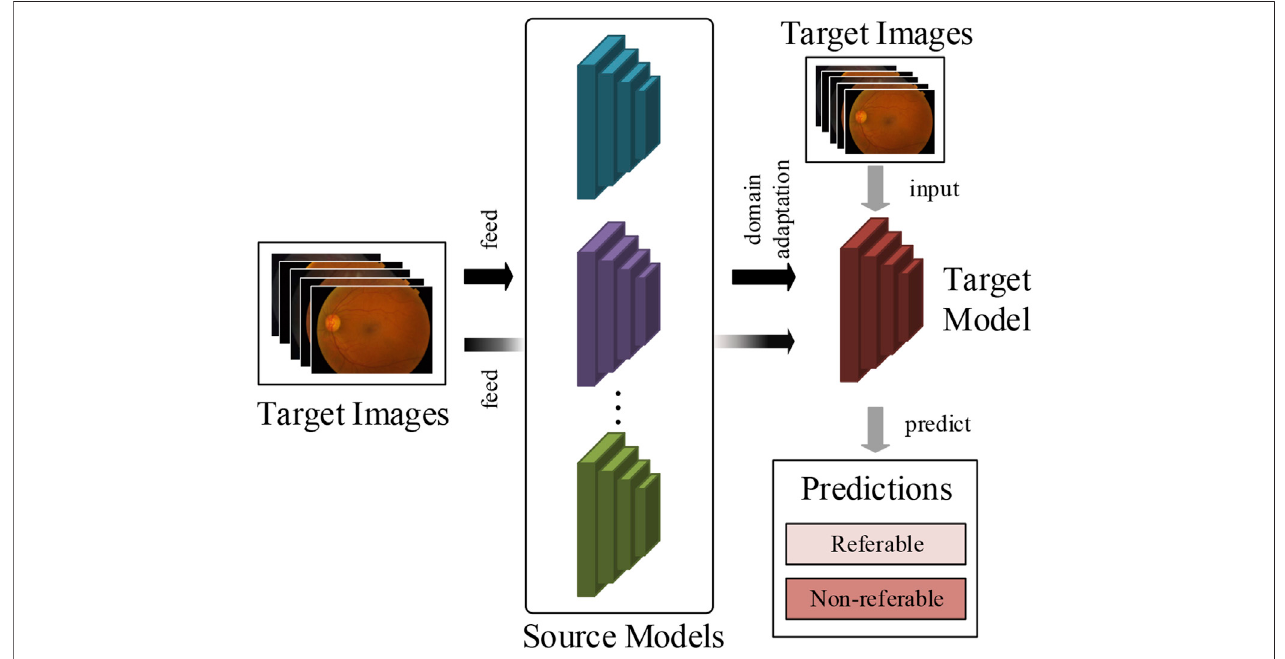
FIGURE1| Thework fl owofourmethod.Wetrainthetargetpredictionmodeltosimplyusepre-trainedmultiplesourcemodelsandunlabeledtargetretinalimages.